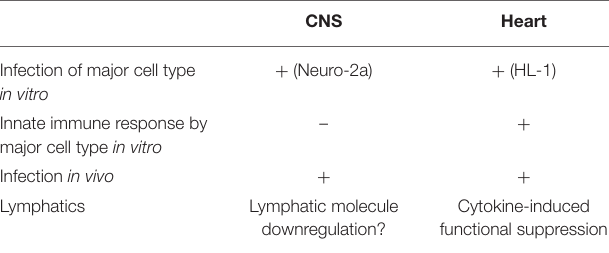
TABLE 1 | Potential factors contributing to TMEV-induced organ-specific